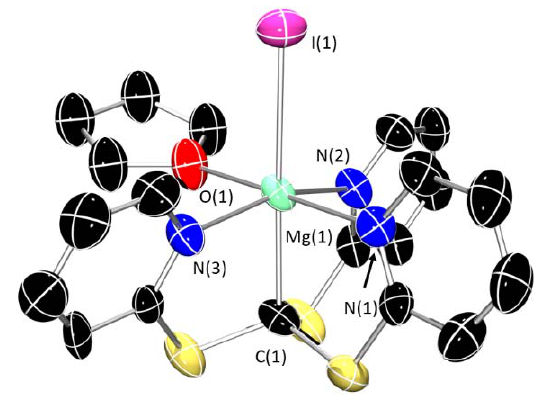
Figure 5. X-ray crystal structure of 1-I ∙ THF. Ellipsoids are set at 50% probability level, and hydrogen atoms and disordered THF have been excluded for clarity. C: black; N: blue; S: yellow; Mg: aquamarine; I: purple; O: red. Selected bond lengths (Å) and angles (°): Mg(1)–C(1) 2.265(15), Mg(1)–N(1) 2.232 (12), Mg(1)–N(2) 2.224(13), Mg(1)–N(3) 2.213(13), Mg(1)–I(1) 2.886(5), N(1)–Mg(1)–N(3)